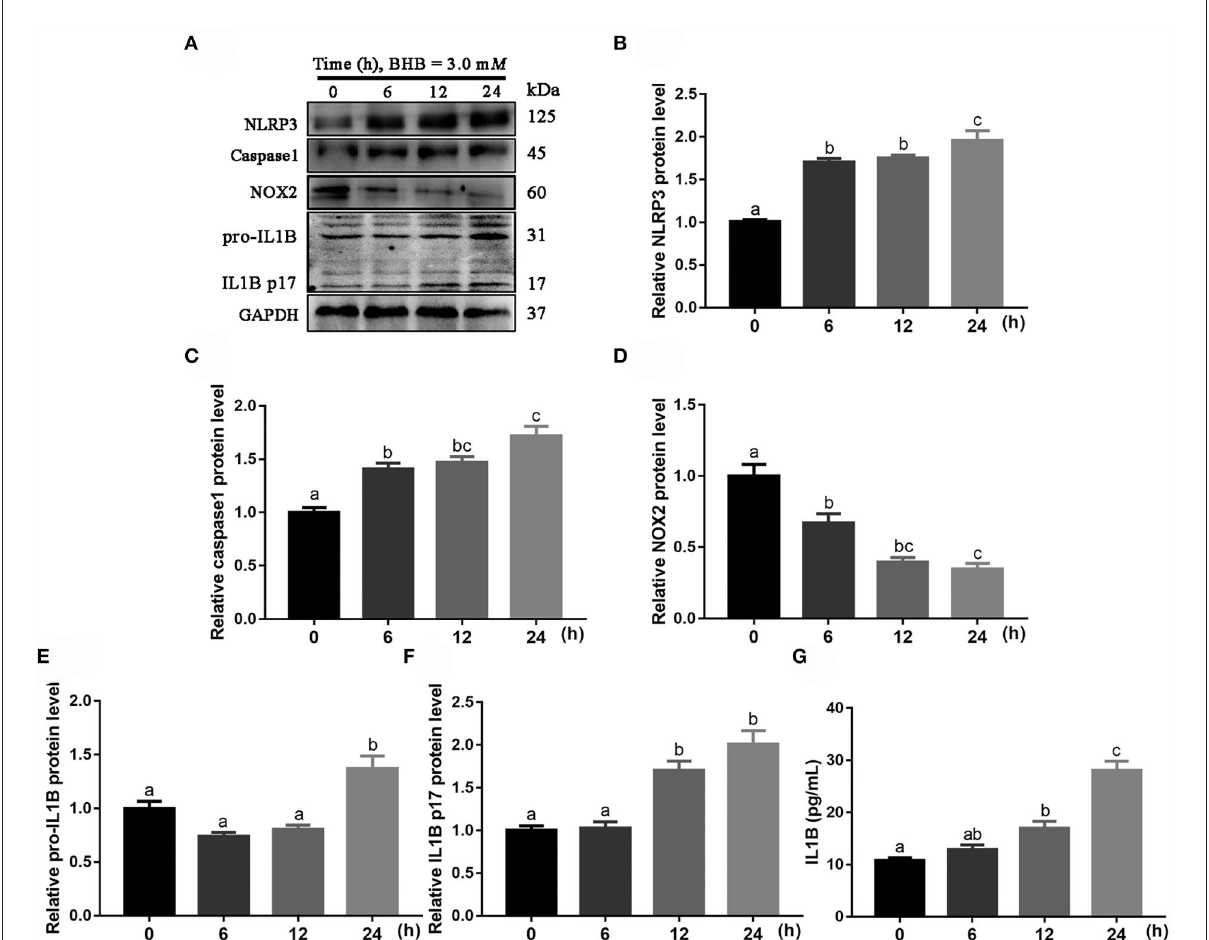
FIGURE7 Effects of β -Hydroxybutyrate (BHB) on NLRP3 signaling pathway of CD14 + monocytes. The monocytes were treated with 3.0 m M of BHB for 0, 6, 12 or 24h. (A) Western blot analysis of NLRP3, caspase 1, NOX2, pro-IL1B and IL1B p17. (B) Protein abundance of NLRP3. (C) Protein abundance of caspase 1. (D) Protein abundance of NOX2. (E) Protein abundance of pro-IL1B. (F) Protein abundance of IL1B p17. (G) Medium concentration of IL1B. Comparisons among groups were calculated using a one-way ANOVA with subsequent Bonferroni correction. Data are means ± SEM of three independent experiments. Different lowercase letters in the bar chart indicate significant differences ( P <